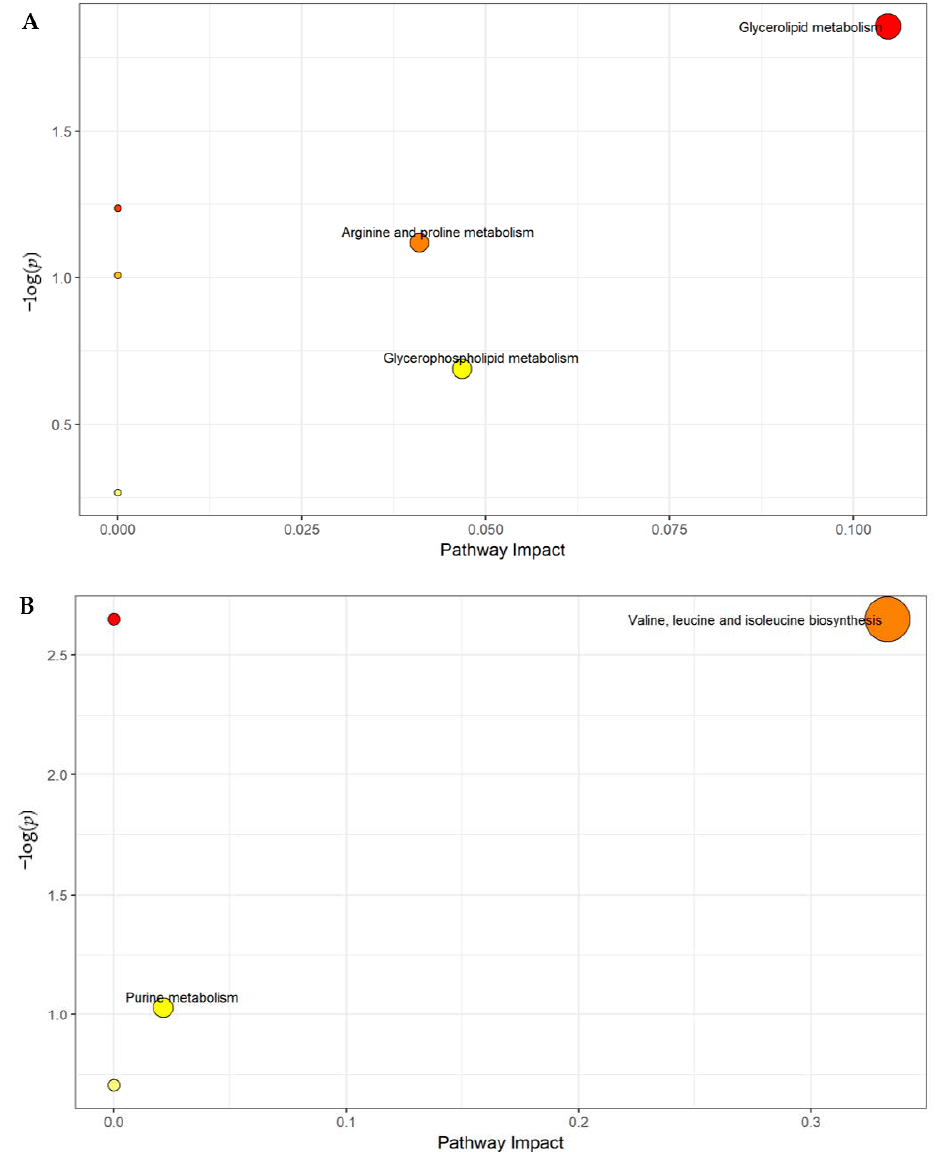
Figure 5. Pathway topology analyses of serum ( A ) and urine ( B ) metabolites of Hu lambs treated with either control or mannan oligosaccharides milk replacer. Lambs were fed milk replacers with or without 0.2% mannan oligosaccharides (MOS; n = 12 per treatment). The serum and urine metabolites in 24 lambs divided into two groups based on MOS supplementation are shown for the 3–week collection phase of the study.